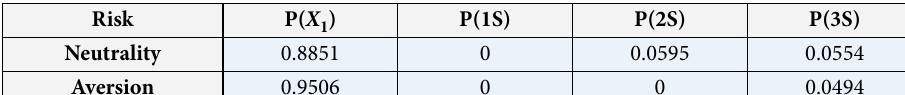
Table 11. Equilibrium probabilities in the four observations setting